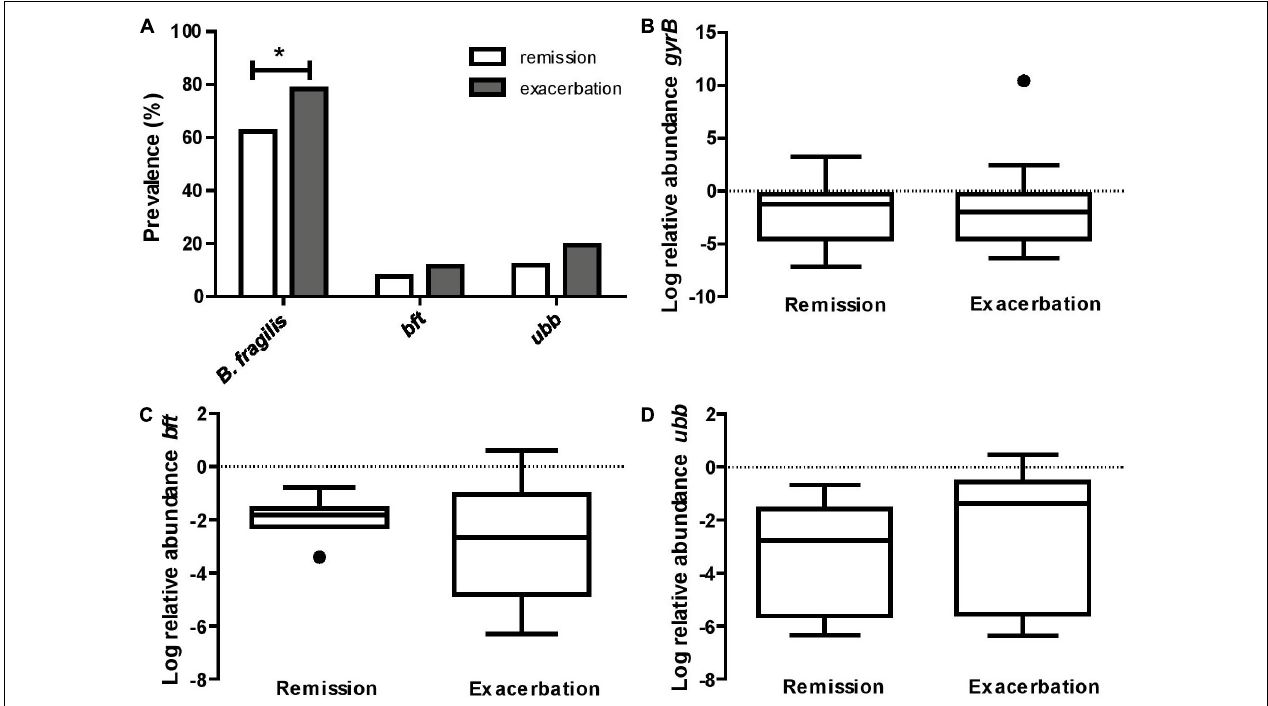
FIGURE 1 | B. fragilis is more prevalent in CD exacerbation samples. (A) The prevalence of B. fragilis specific gyrB is 16.0% higher in active CD compared to remission (* p = 0.018), while the prevalence of the virulence factors bft and ubb does not differ significantly between groups ( p = 0.376 and p = 0.164, respectively). The relative abundance of gyrB (B) , bft (C) , and ubb (D) , based on 16S rRNA gene copy number, does not significantly differ between active CD and remission ( p = 0.837, p = 0.283 and p = 0.196,